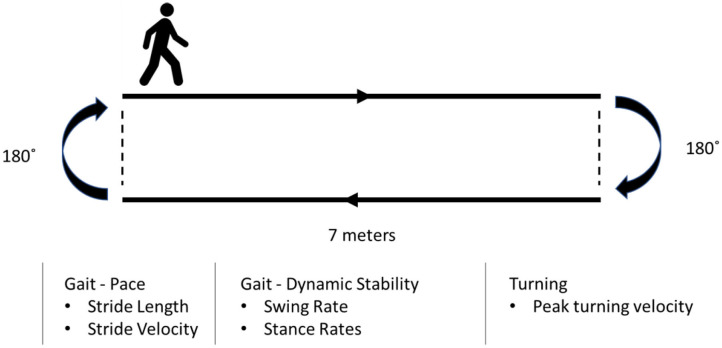
The schematic of the walking task.